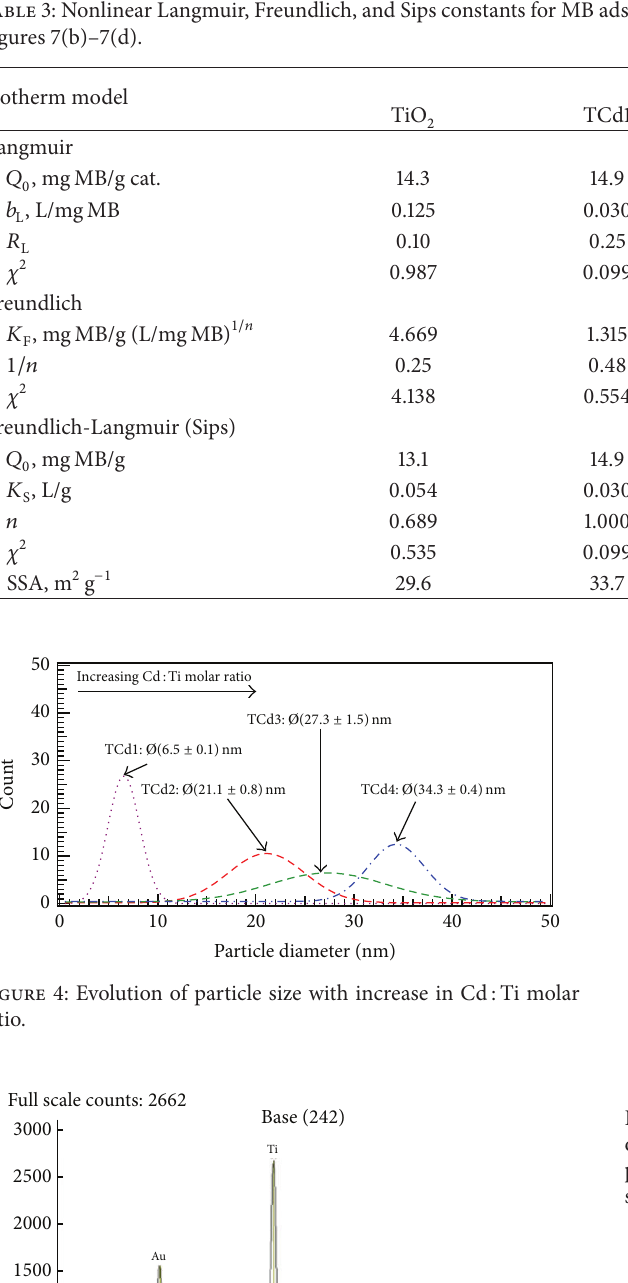
correlation obtained with these models indicate that they are adequate representations of MB sorption by the samples.